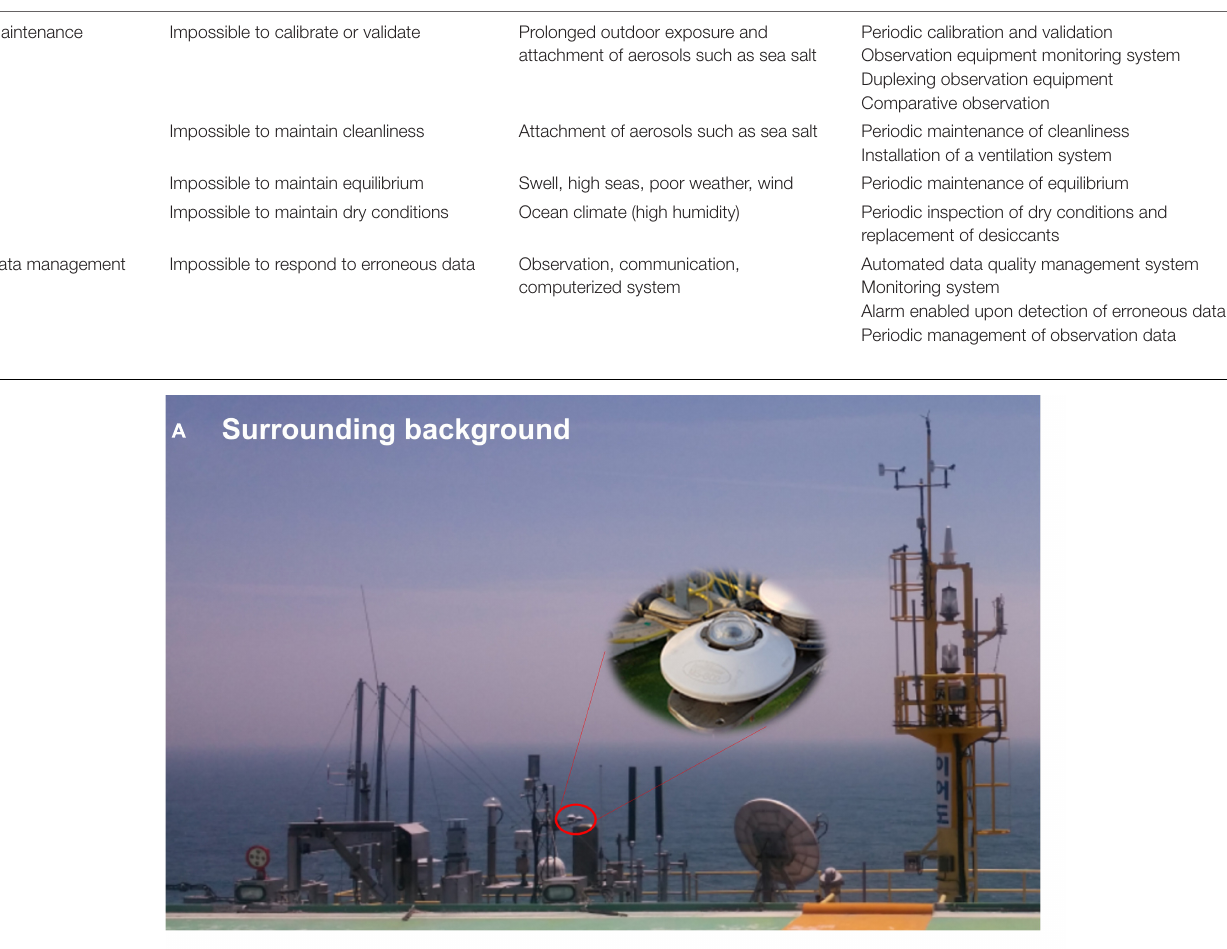
TABLE 1 | Evaluation of challenges in automated radiation observation at Ieodo Ocean Research Station (Ieodo ORS). Classification